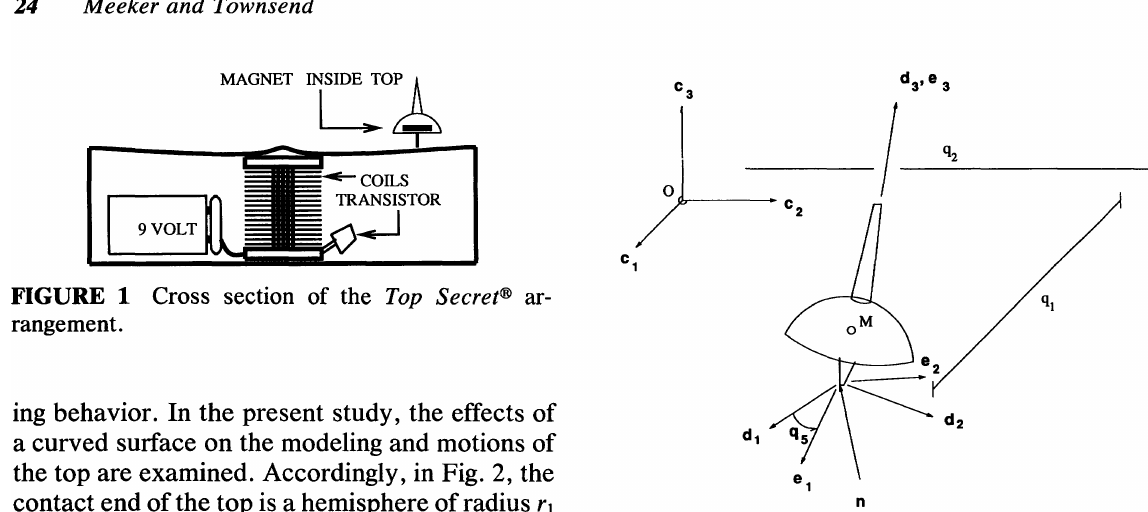
n FIGURE 3 Explanation of reference